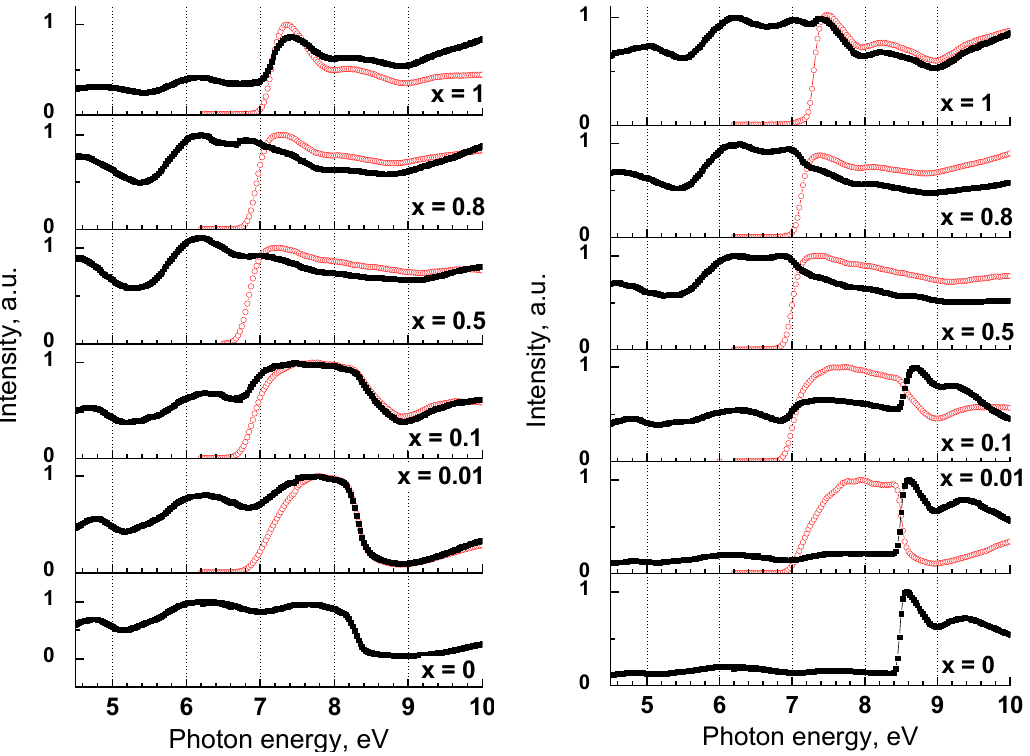
Figure 4. Excitation spectra of Y 1 − x Sc x PO 4 for the UV-C emission (red circles) and defect-related emission (black squares) at 300 ( left panel ) and 7 K ( right panel